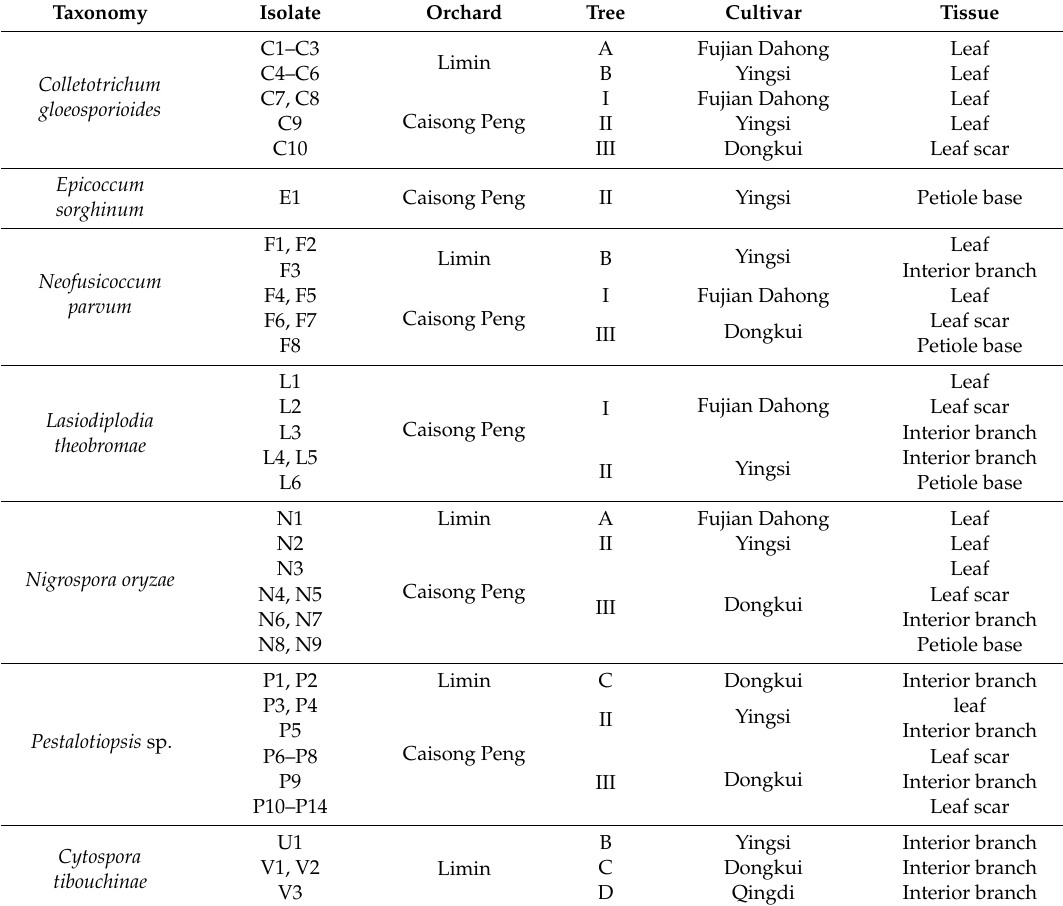
Table 2. Fungal isolates and tentative taxonomic categories according to the ITS , tef1- α and tub2